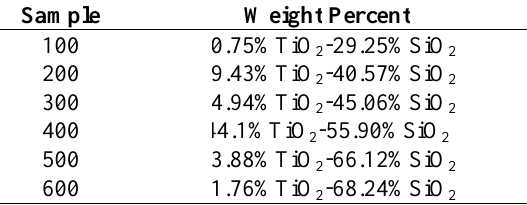
Table 2. The result of XRF analysis.